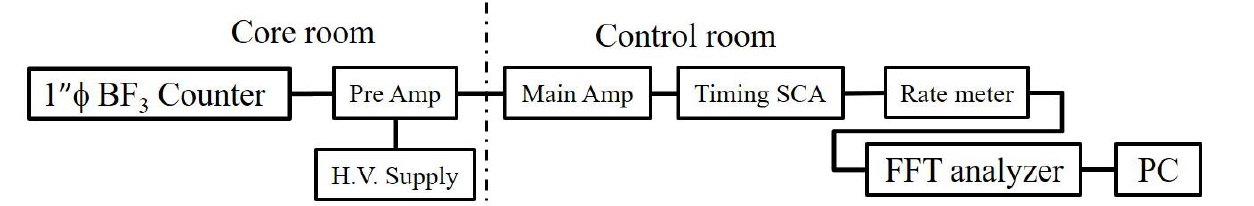
Figure 2. Measurement system of employed in the present